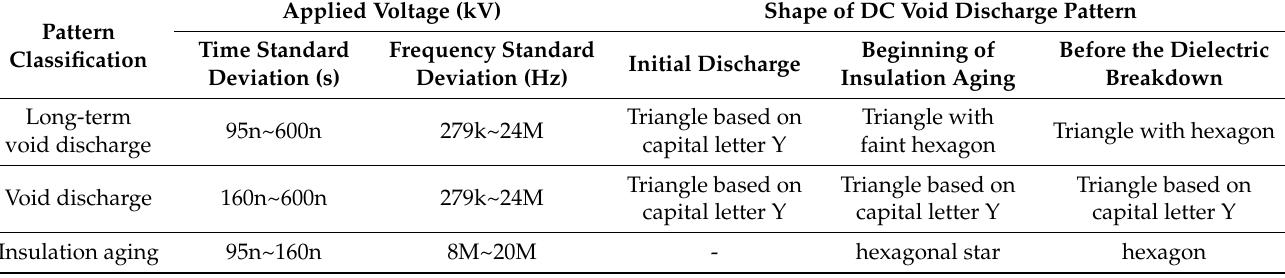
Table 4. DC void discharge characteristics and patterns according to the long-term insulation aging classified through TF